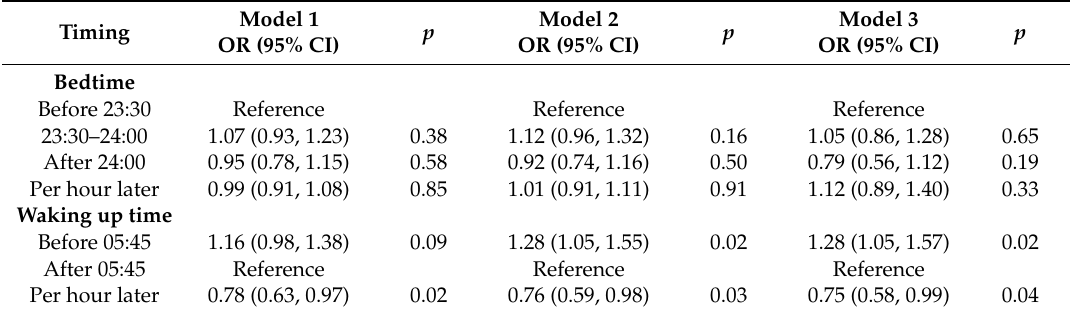
Table 2. Cross-sectional association between sleep timing and body mass index (BMI) Z-score ( n = 965).